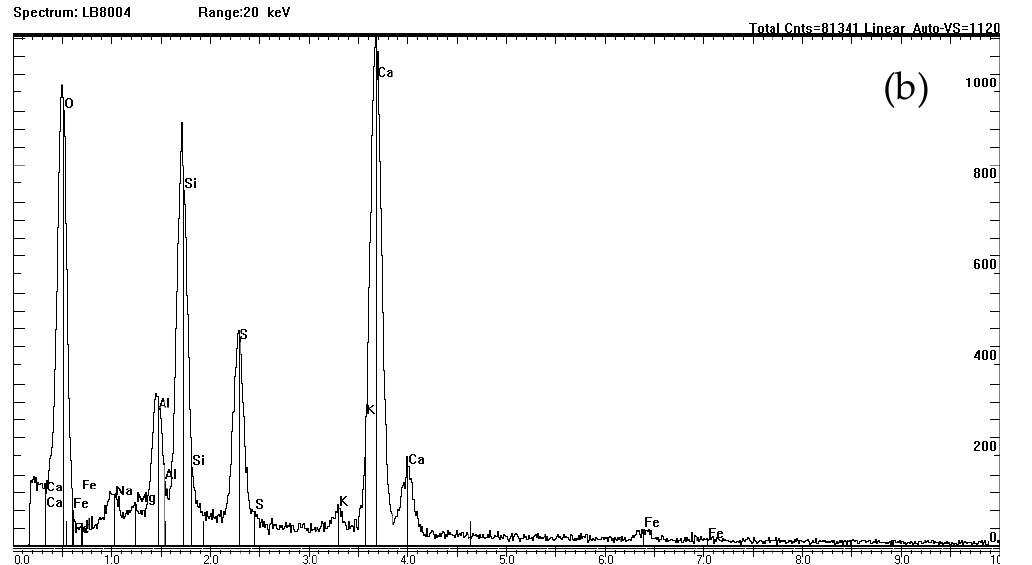
Figure 1. ( a ) SEM image of damage in a concrete sample immersed in sodium sulfate solution with 8% concentration for 250 days, and ( b ) the energy spectrum of ettingite.